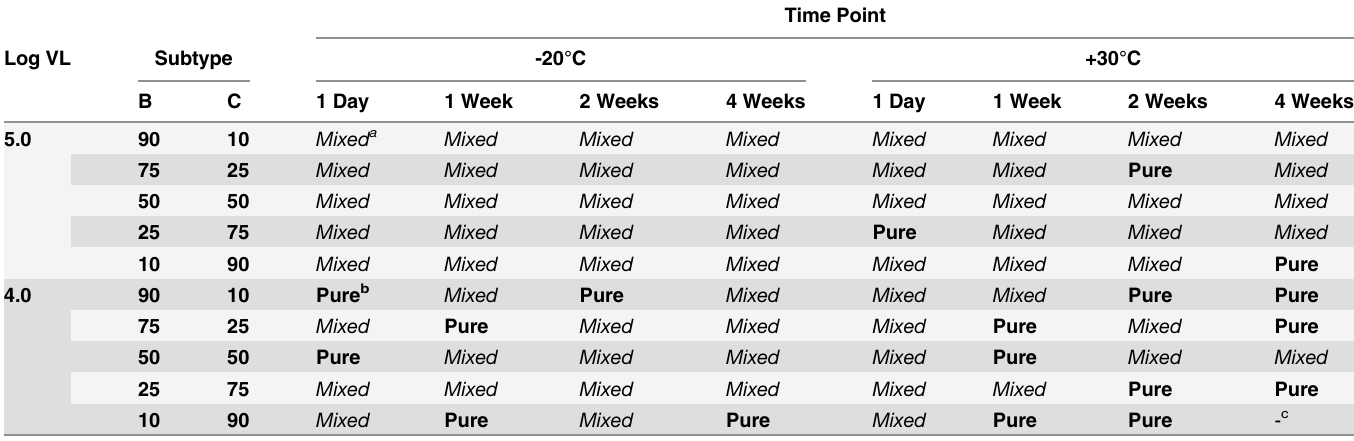
Table 1. Detection of mixed viral populations in dried blood spot samples with two different viral loads, stored at -20°C or +30°C for four different time periods.